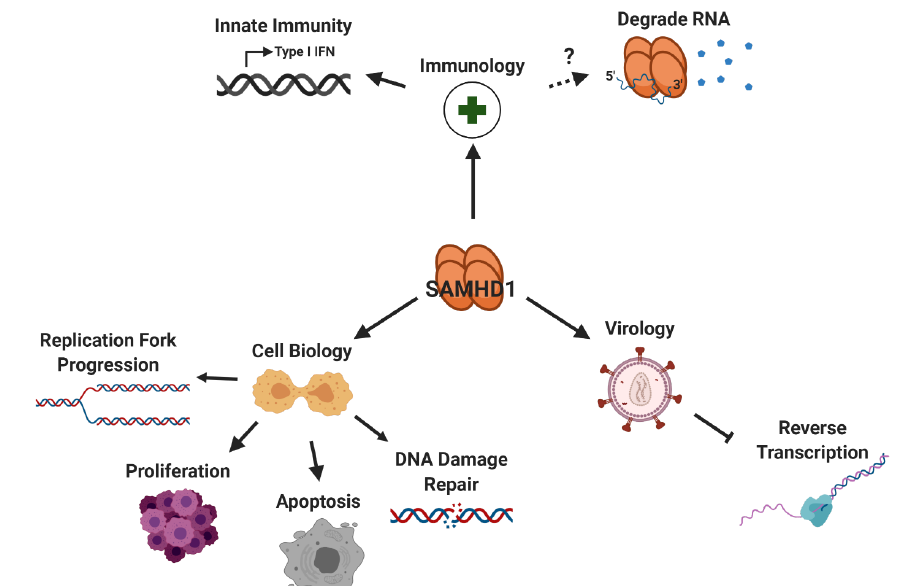
Figure 1. SAMHD1 plays a variety of roles in virology, immunology, and cell biology. The dNTPase activity of SAMHD1 depletes intercellular dNTP pools in macrophages, restricting reverse transcription of HIV-1 in this cell type. Similarly, SAMHD1 has been found to restrict the viral replication of other DNA and RNA viruses. In addition to viral restriction, SAMHD1 facilitates replication fork progression, is implicated in cell proliferation and apoptosis, and is localized to sites of DNA damage. As a negative regulator of IFN I, SAMHD1 is commonly mutated in a disease that phenotypically resembles a congenital viral infection called AGS. The controversial exonuclease activity of SAMHD1 would negatively regulate host innate immunity as aberrant host and viral nucleic acids could serve as potential degradation targets. Figures 1–3 were created with BioRender.com.